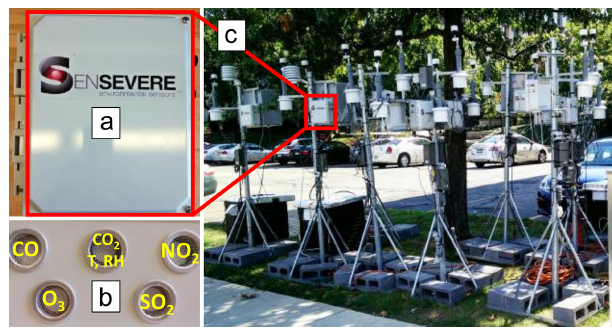
Figure 1. Photographs of the RAMP monitors and the sampling setup. (a) Front view of the RAMP unit in the NEMA-rated en- closure. (b) Bottom view of the RAMP monitors with sensor lay- out labeled in yellow. (c) Example of collocation setup using tripod mounting (not pictured: supersite containing the reference monitors, immediately beside the